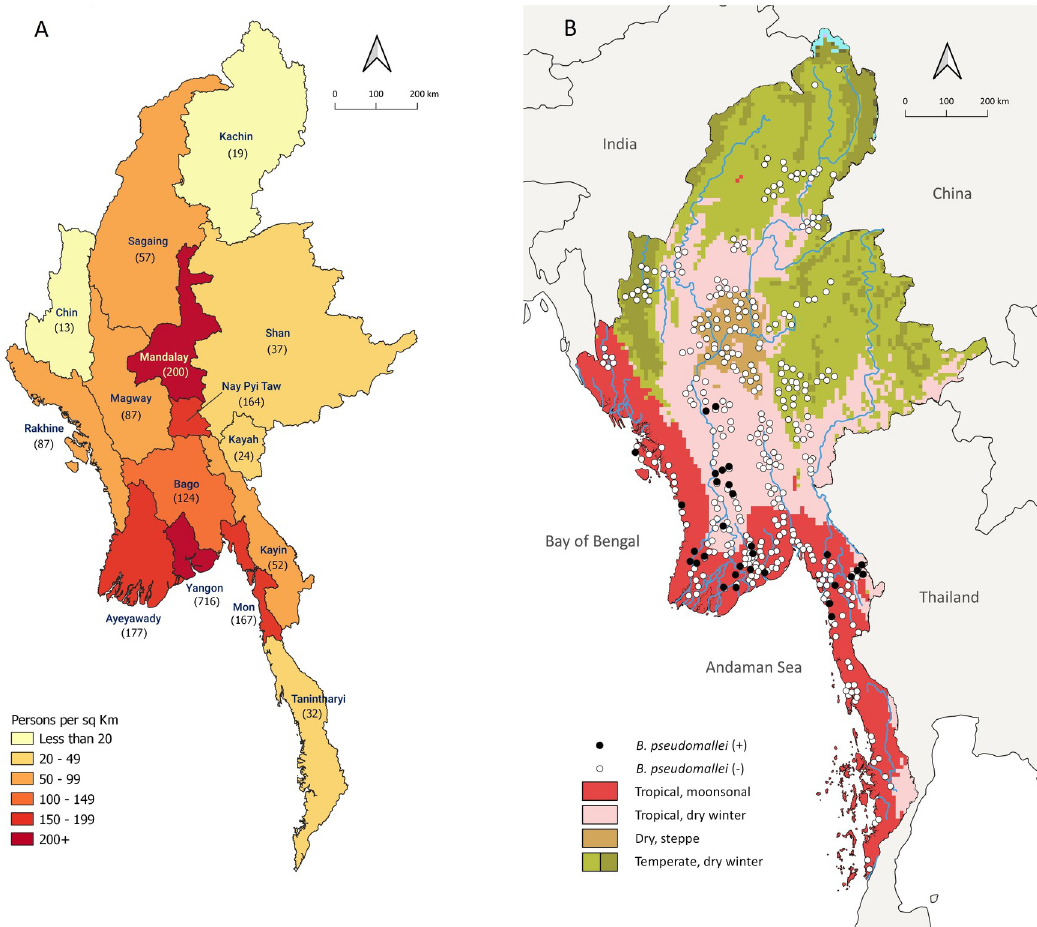
Fig 1. Distribution of B . pseudomallei positive sites across the country. A. Map of the states and regions of Myanmar with corresponding population density (person per square km). B. Map of Myanmar climate zones based on the Koppen Geiger climate classification (Source: http://koeppen-geiger.vu-wien.ac.at/present.htm). Black dots represent B . pseudomallei -positive sites (at least one sample positive for B . pseudomallei ) and white dots represent B . pseudomallei -negative sites).